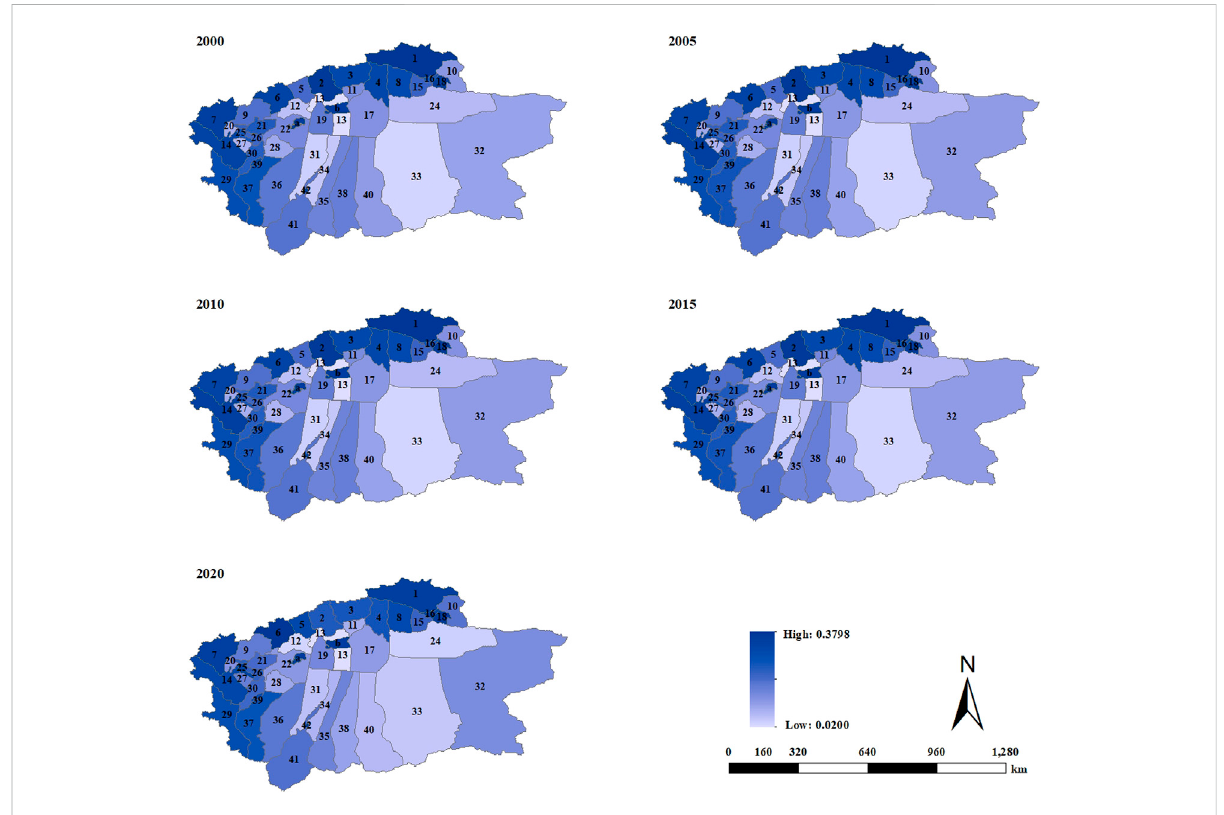
FIGURE 5 Spatial distribution of eco-environmental quality in different